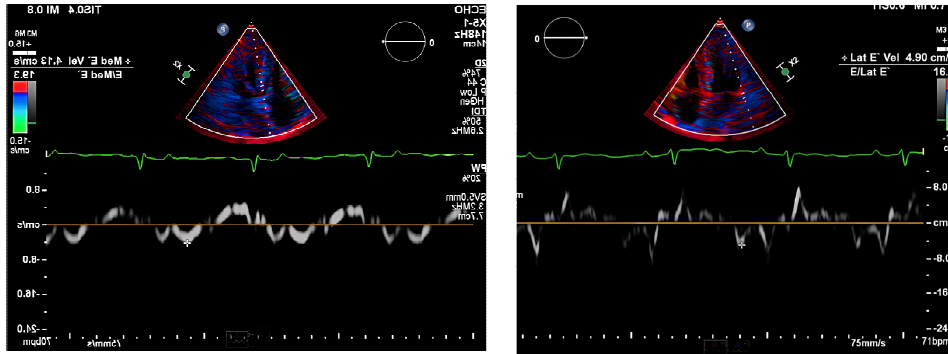
Figure 3. Pulse-wave Tissue Doppler ECHO showing elevated E/E ′ ratio and low mitral annulus velocities suggestive of diastolic dysfunction .